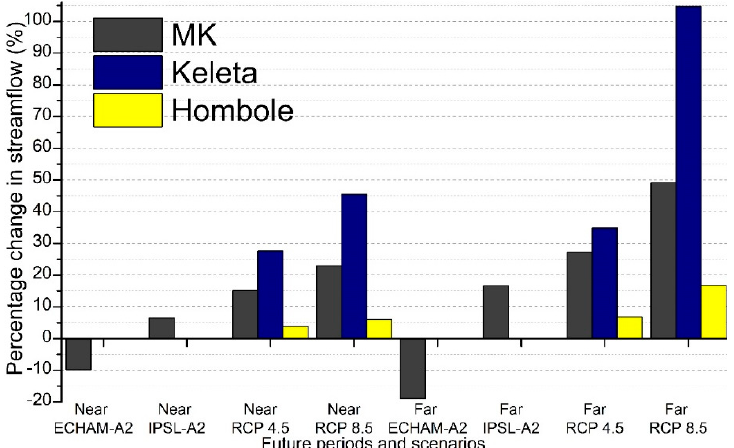
Figure 18. Comparison of projected percentages changes in streamflow (%) in the MK, the Keleta and the Hombole subbasins.